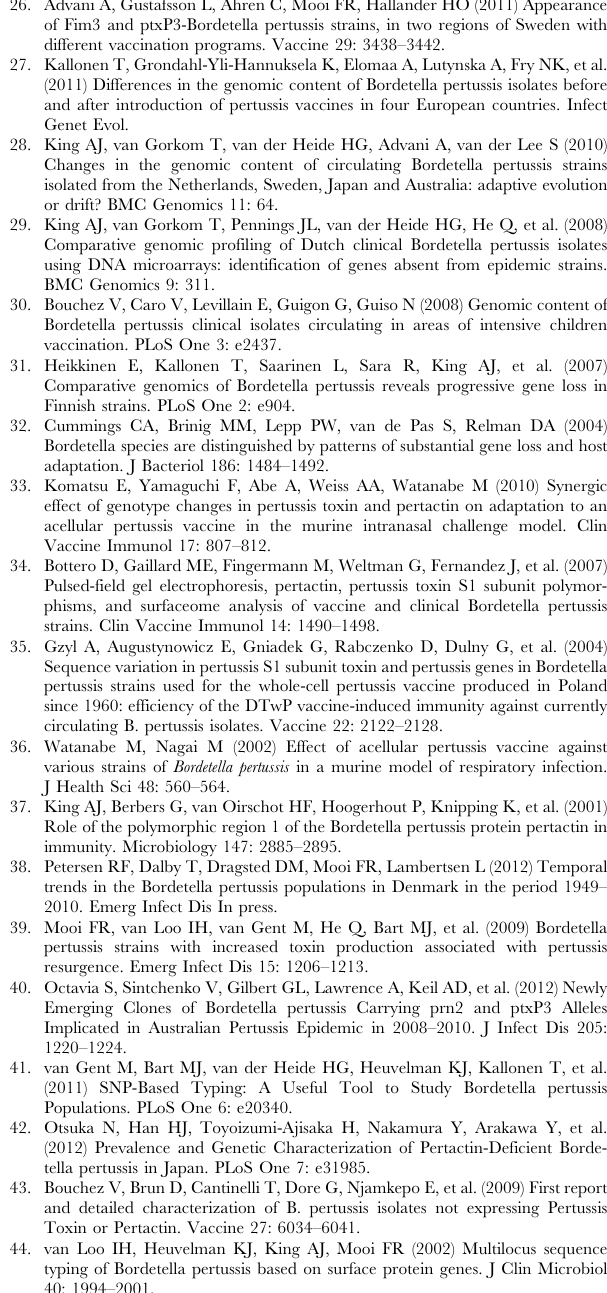
clustered according to their position in the phylogenetic tree as shown in Fig. 1. Colouring of ATs is as in Fig. 1. Abbreviations: AT, allele type; ST, sequence